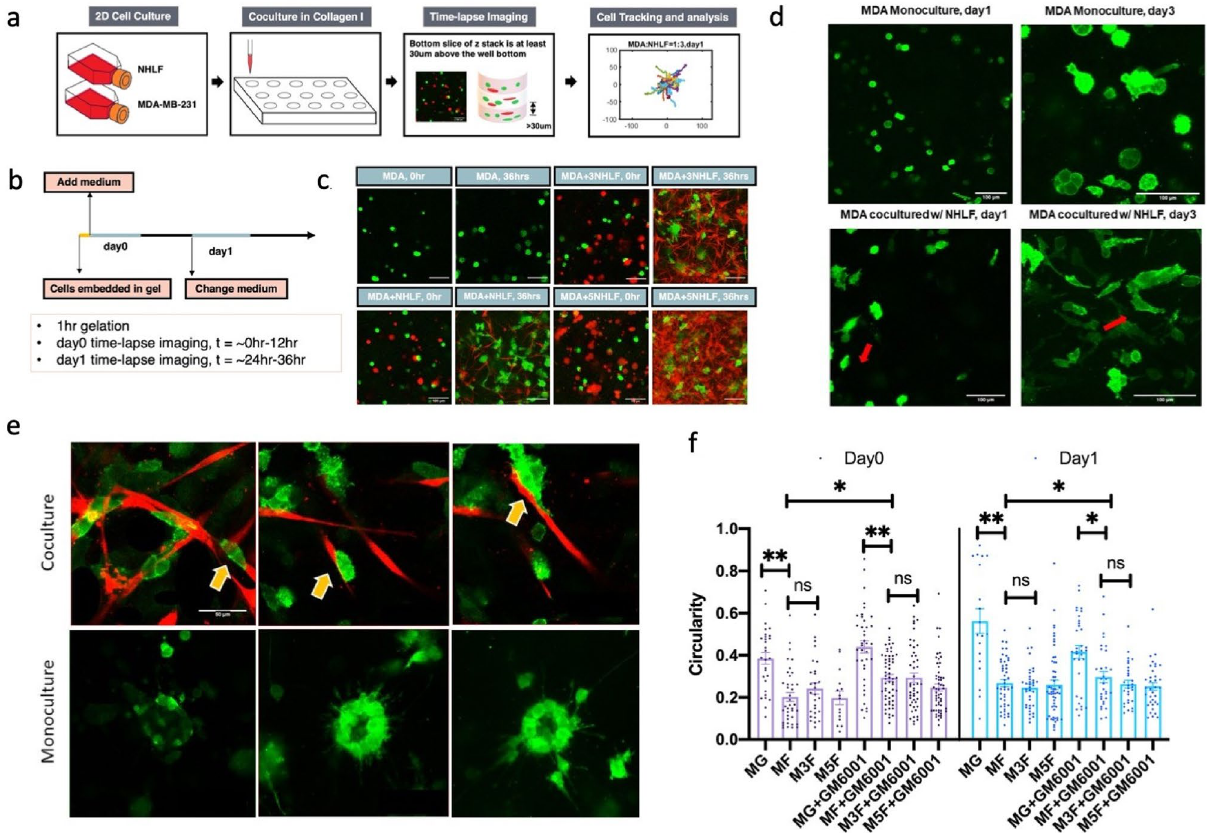
Figure 1. Experiment set-up of the in vitro MDA-MB-231 + NHLF coculture. ( a ) Brief introduction to the pipeline. ( b ) Diagrams show the timeline of the image acquisition. ( c ) Representative images of MDA-MB-231 (shortened as MDA, shown in green channel) and normal human lung fibroblast (shortened as NHLF, shown in red channel). "MDA" indicates MDA-MB-231 monoculture, "MDA + NHLF" indicates co-culture with initial cell concentration ratio between MDA-MB-231 and NHLF of 1:1; "MDA + 3NHLF" indicates co-culture with initial cell concentration ratio between MDA-MB-231 and NHLF of 1:3; "MDA + 5NHLF" indicates co-culture with initial cell concentration ratio between MDA-MB-231 and NHLF of 1:5. The scale bar is 100 µm. ( d ) MDA-MB-231 morphology in long term culture. Scale bar is 100 µm. ( e ) MDA-MB-231 (green) in close contact with NHLF (red) can be seen in co-culture conditions (top row). In monoculture, petal-like structure can be seen after around 4–5 days post cell embedment. Scale bar is 50 µm. ( f ) Circularity of MDA-MB-231 cells on day0 and day1. For MDA-MB-231 monoculture, at least 15 cells were traced and for cocultures, around 30 cells traced. Data were collected from two independent experiments with four replicates. One way ANOVA with post-hoc Tukey HSD Test was performed. * p < 0.05, ** p <